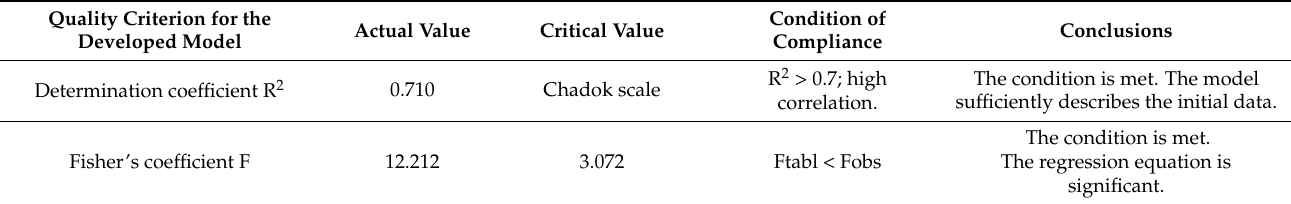
Table 3. Quality indicators of the security zone area model.